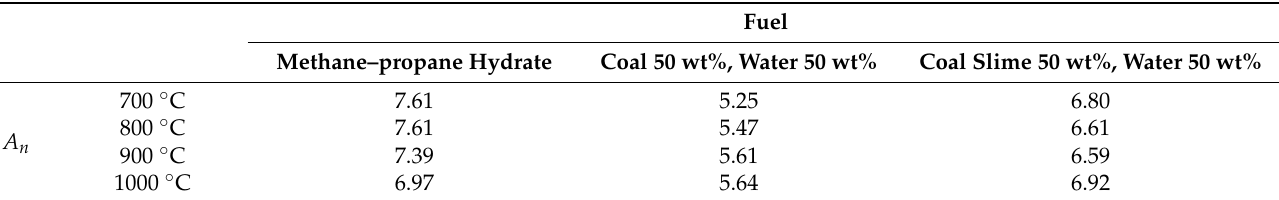
Table 7. Total fuel combustion efficiency indicators ( A n